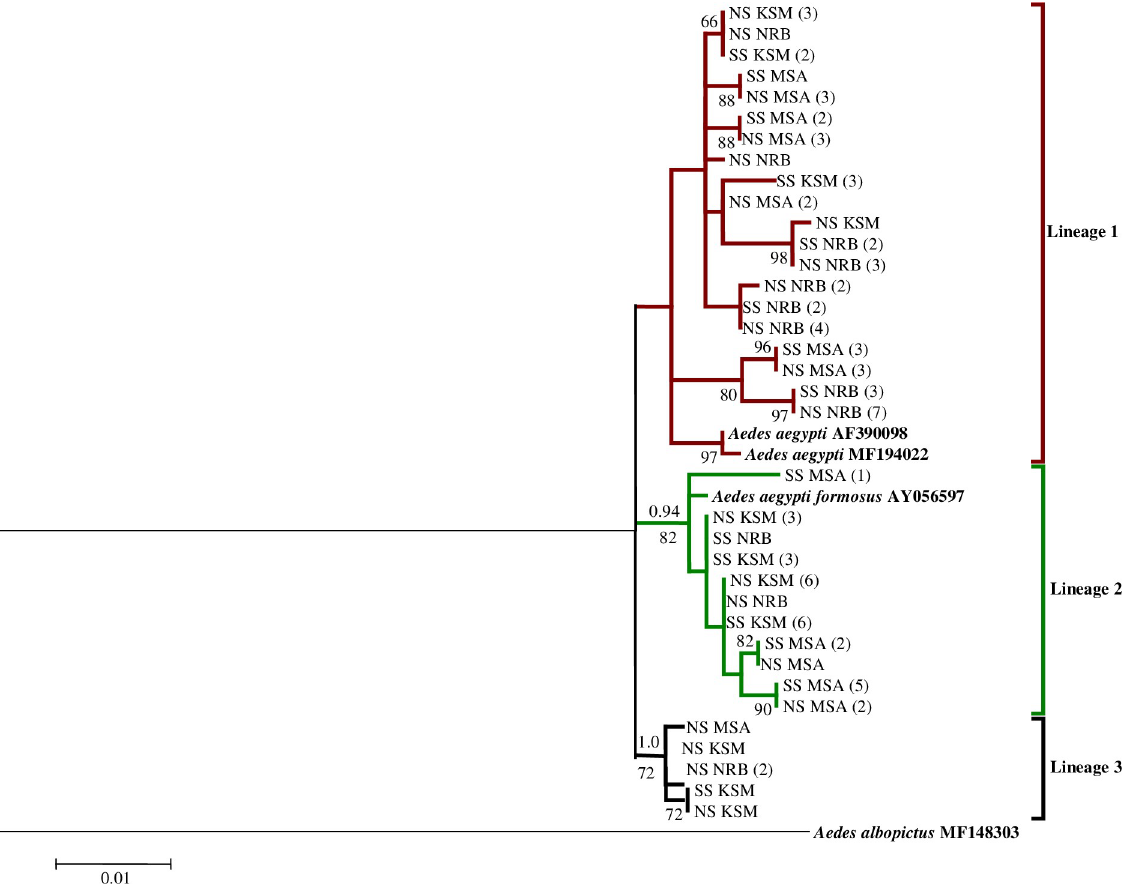
Fig 3. Maximum likelihood tree inferred using the (GTR+G) model of sequence evolution for COI barcode region (860 bp) of dengue virus susceptible (SS) and non-susceptible (NS) Aedes aegypti mosquitoes from Mombasa (MSA), Kisumu (KSM), and Nairobi (NRB), Kenya. The number of individuals sharing a haplotype is indicated in parentheses. Bayesian posterior probabilities � 0.90 and bootstrap support values from 5,000 replications � 65 are indicated above and below the three major lineages, respectively, with terminal nodes reflecting bootstrap support values alone. Aedes albopictus was included for outgroup